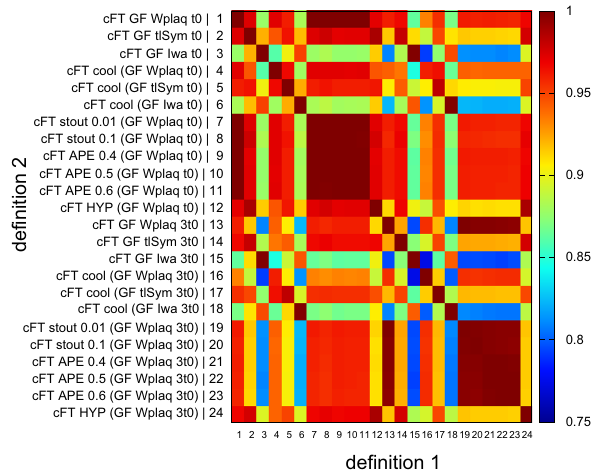
Fig. 14 Comparison of field theoretic definitions with different kinds of smoothing of UV fluctuations. The correlation between differ- ent definitions is colour-coded (note the scale is different than in Figs. 9, 10, 15,